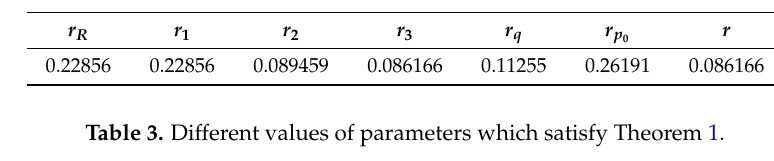
Table 2. Different values of parameters which satisfy Theorem 1.